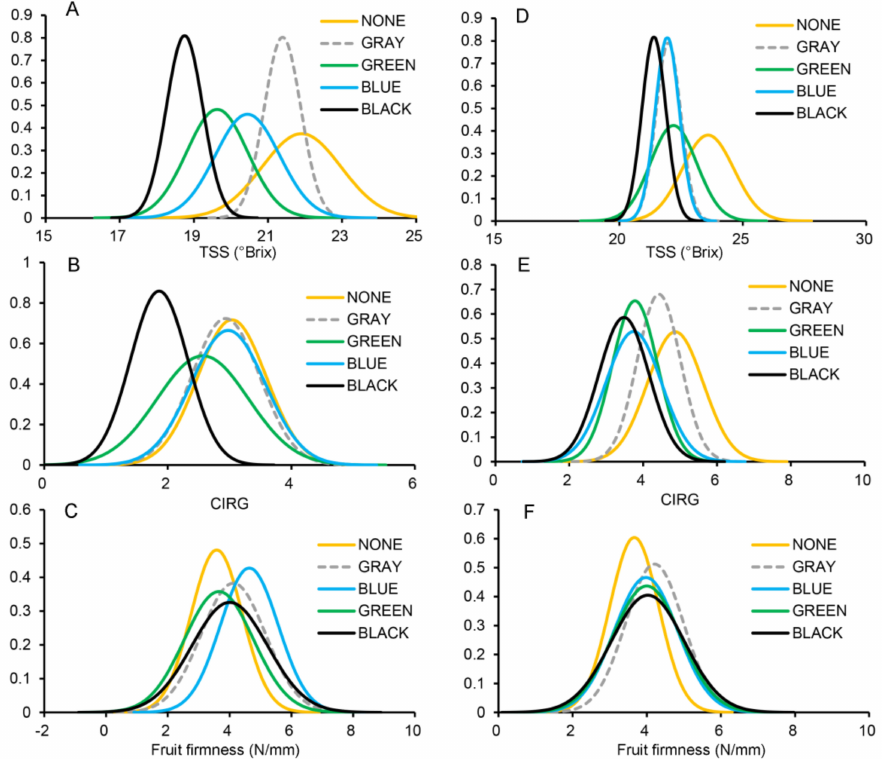
Figure 3. Differences in TSS, CIRG, and fruit firmness across the different treatments. TSS, CIRG, and fruit firmness, at PQ ( A – C ) and ZH ( D – F ). NONE, no shading; GRAY, BLUE, GREEN, and BLACK, shade net